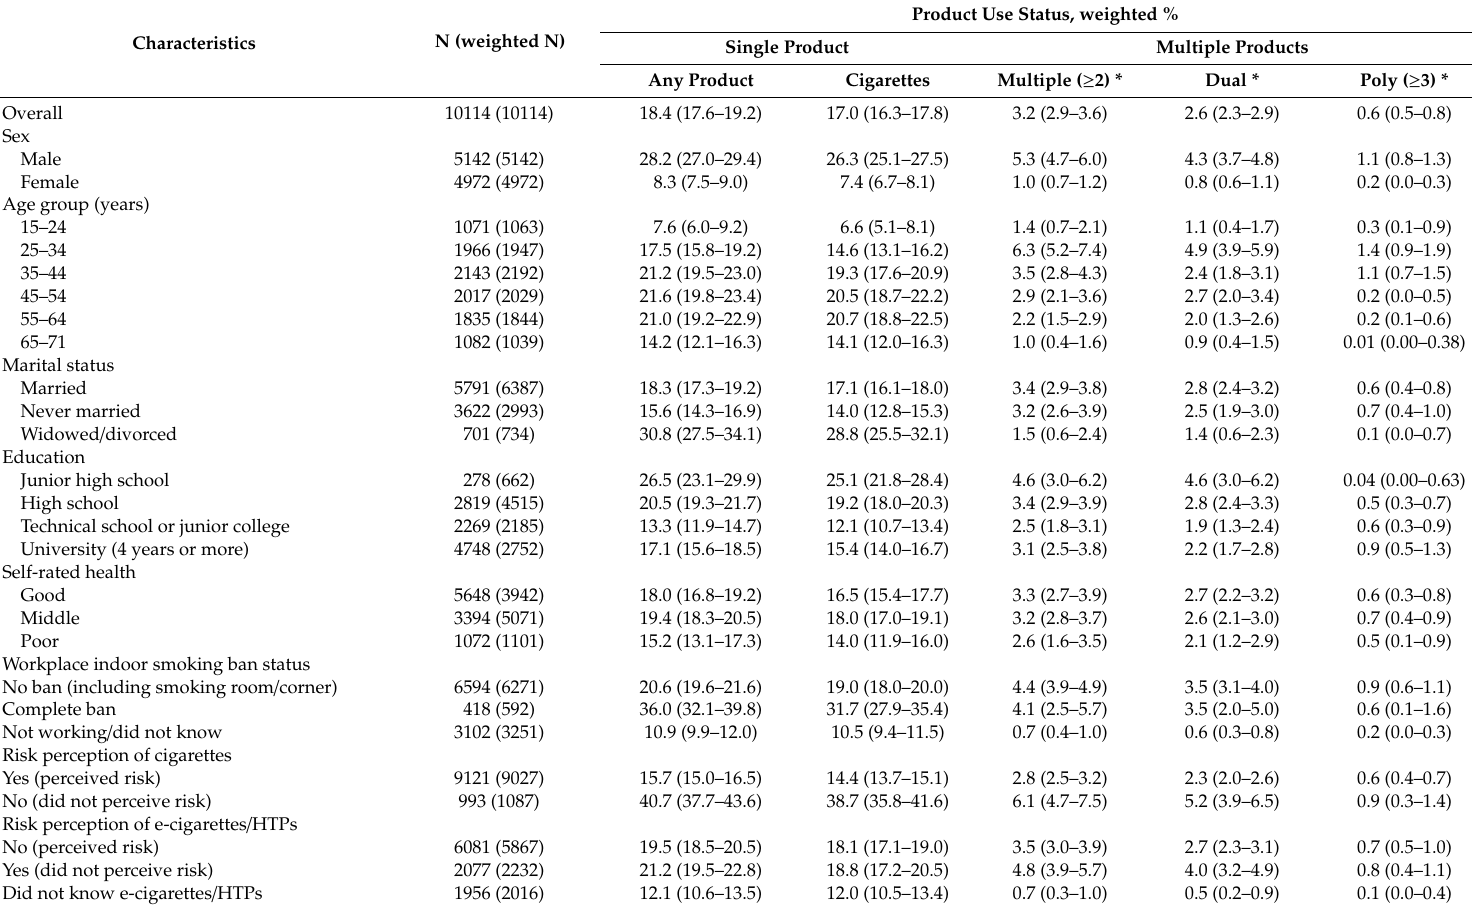
Table 2. Percentages of current product use status according to